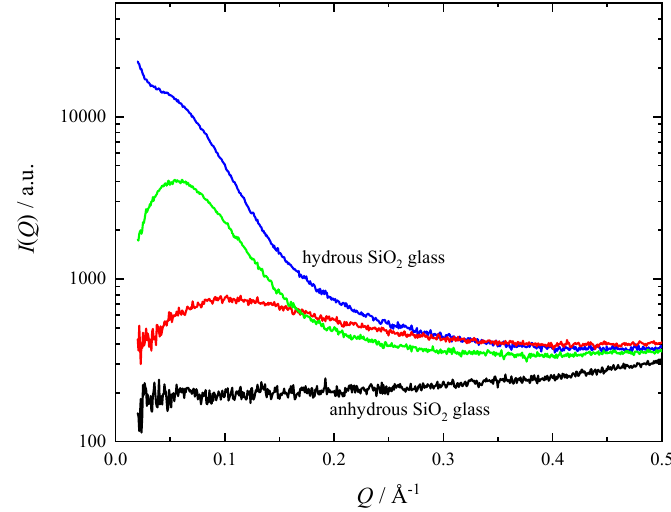
Figure 2. Small angle X-ray scattering intensity from the hydrous SiO 2 glass at ambient conditions. Scattering intensity from anhydrous SiO 2 glass (black curve) is also shown for comparison. Three curves were observed at locations from a few hundred micrometers to a millimeter apart.